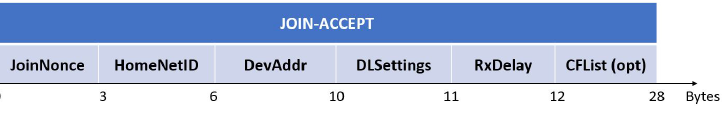
Figure 4. Join response message